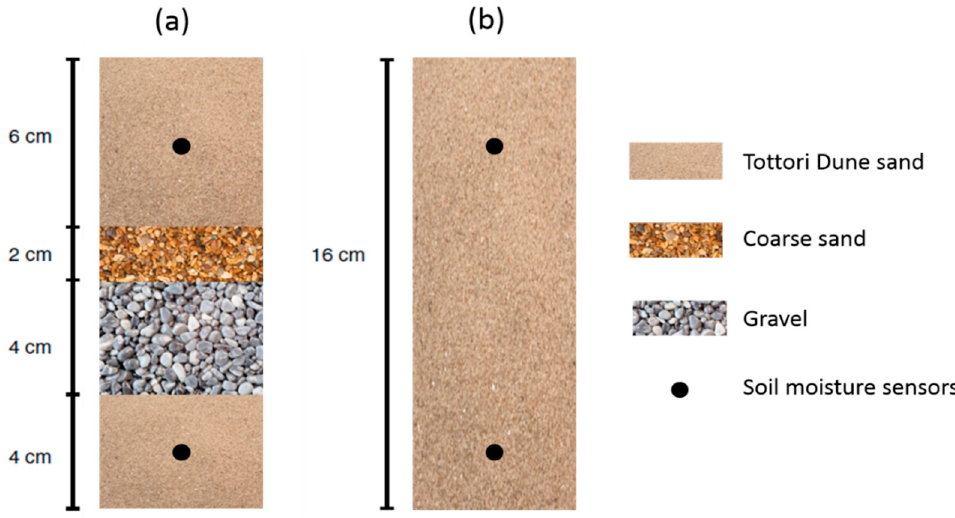
Figure 1. Soil profiles in the cultivation experiment of Miyake et al. [20] with ( a ) and without ( b ) a capillary barrier layer.